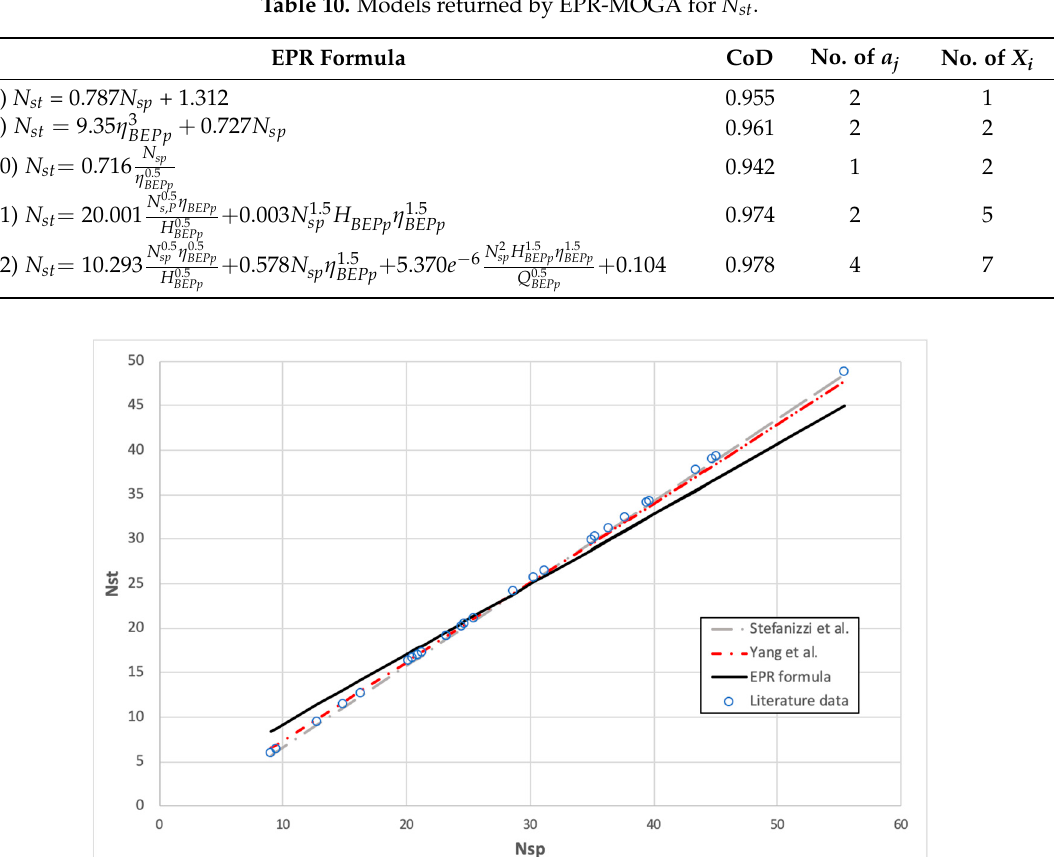
Figure 2. PAT-specific speed versus pump-specific speed.